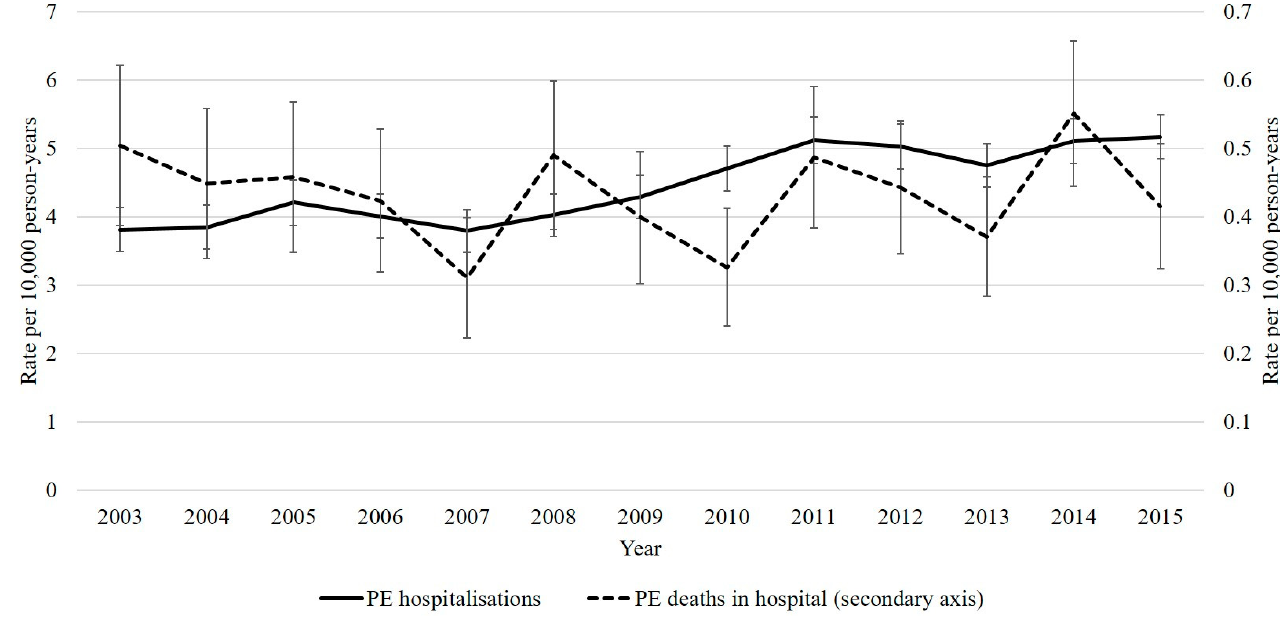
Figure 2. Age-sex standardized rate of PE hospitalizations and rates of death during PE-related hospitalizations, by year. Legend: PE hospitalization defined as a hospitalization with PE as the primary or secondary diagnosis. Death during PE-related hospitalization based on the mode of separation for this set of hospitals. Age-sex standardized to the 2016 Western Australian population aged 20+. Abbreviations: PE, pulmonary embolism